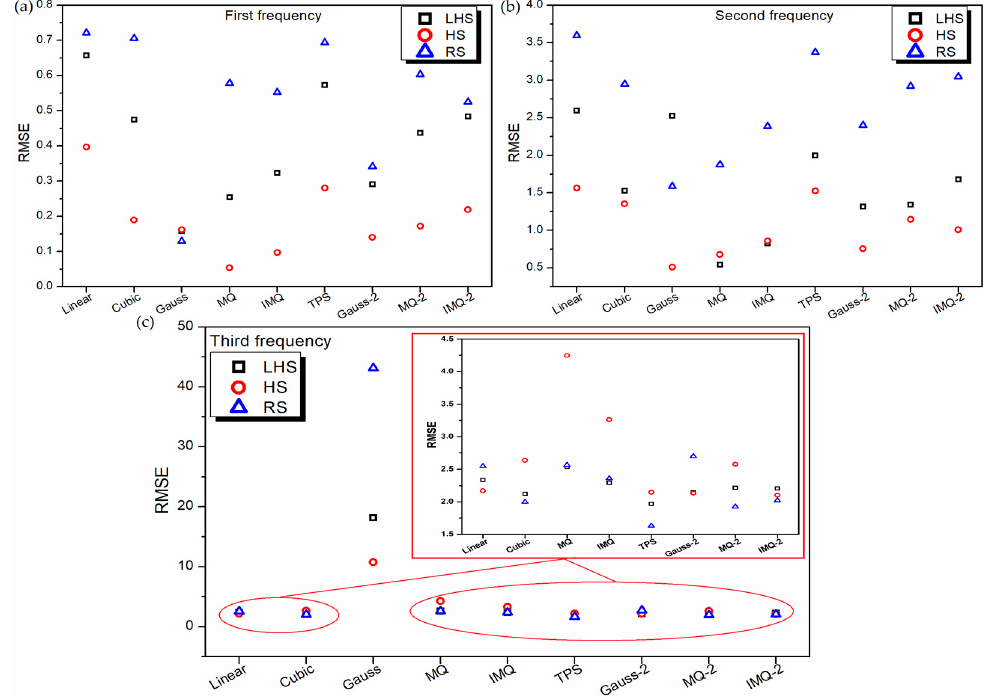
Figure 5. RMSE values of various RBF metamodels in LD problem for testing data.